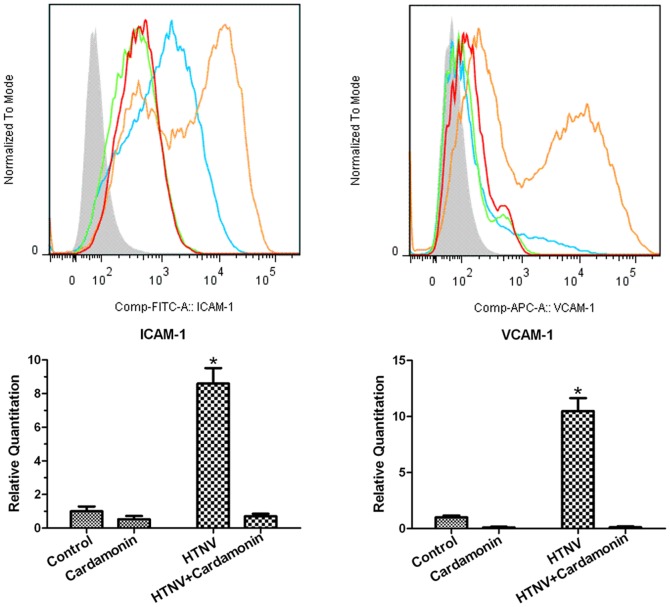
Detection of the expression of ICAM-1 and VCAM-1 in HTNV-infected HUVECs with or without cardamonin treatment.HUVECs were pretreated for 30 μM cardamonin followed by infection with HTNV for the indicated time points. Subsequently, flow cytometric analysis and quantitative real-time PCR analysis were performed as described before. HTNV induced the expression of ICAM-1 and VCAM-1 at the mRNA and protein levels, and this phenomenon was effectively inhibited by cardamonin (*, p<0.05).